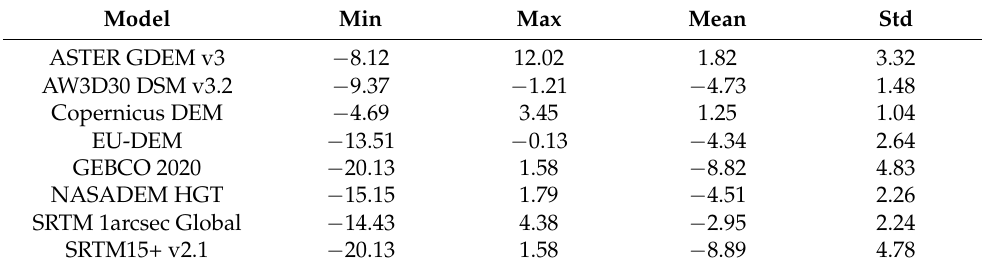
Table 3. Statistics of height differences between models and leveling at Central traverse